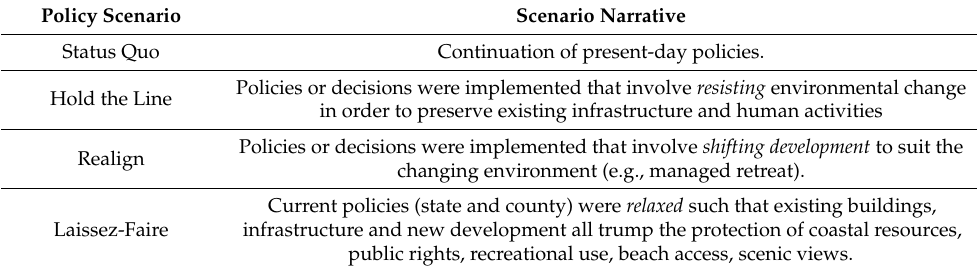
Table 2. Four policy scenario narratives iteratively codeveloped with local stakeholders. Each policy scenario contains a unique grouping of individual policies like those listed in Table